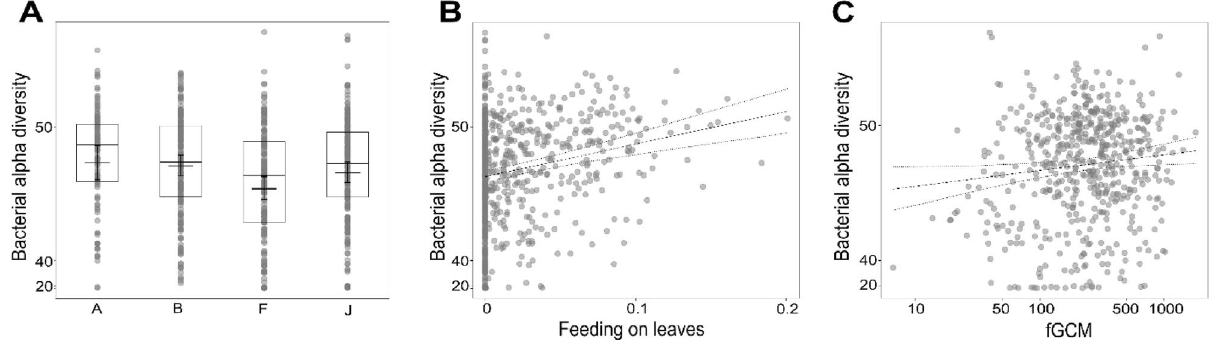
Figure 2. Effects of group membership, consumption of leaves and concentrations of fGCM on bacterial alpha diversity measured as PD. ( A ) Group membership. ( B ) Proportion of time feeding on leaves during the 30 days prior to sampling. ( C ) Log-transformed fGCM concentrations given in ng/g feces.